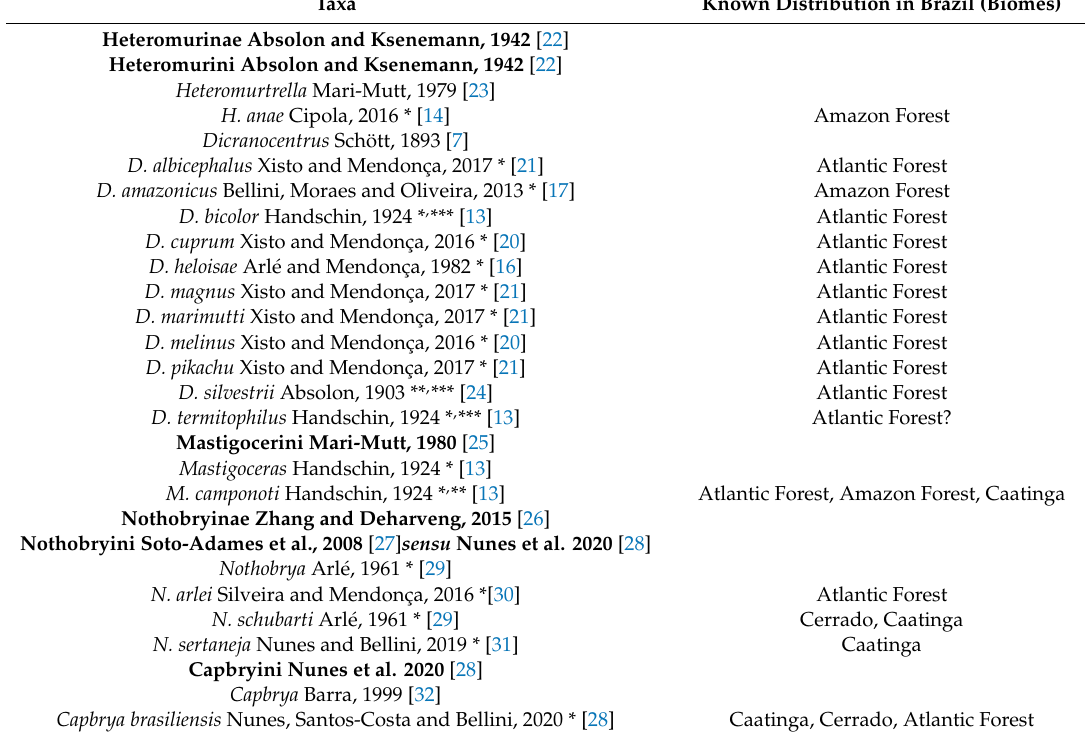
Table 1. List of Brazilian species of Orchesellidae Börner, 1906 sensu Zhang et al. [2] and their known